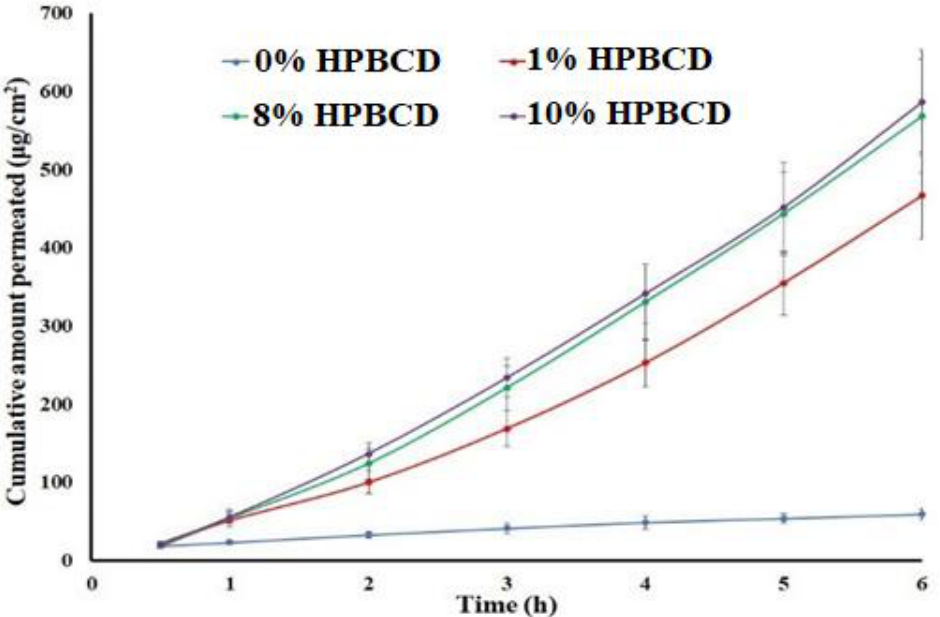
Figure 3. Effect of hydroxypropyl β -cyclodextrin on permeation of saturated solution of desloratadine (in phosphate buffer pH 7.4) through pig ear skin. Data are shown as mean ± SD, n = 6.